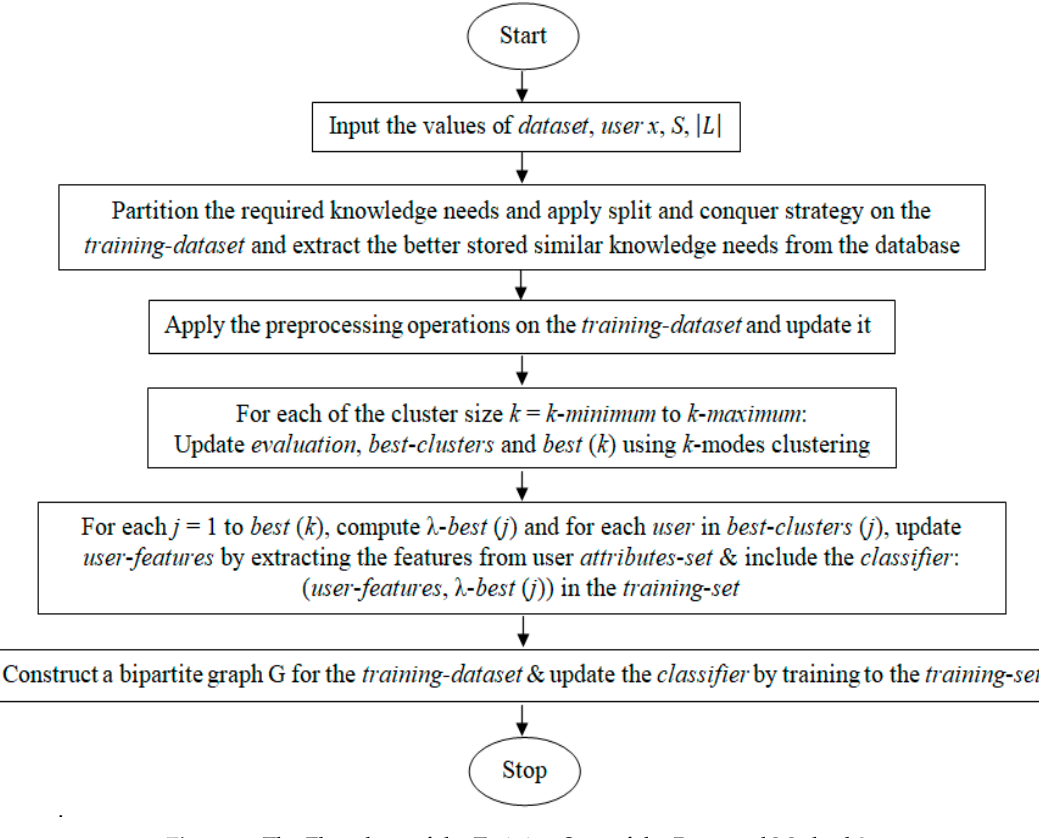
Figure 3. The Flowchart of the Training Step of the Proposed Method 2.